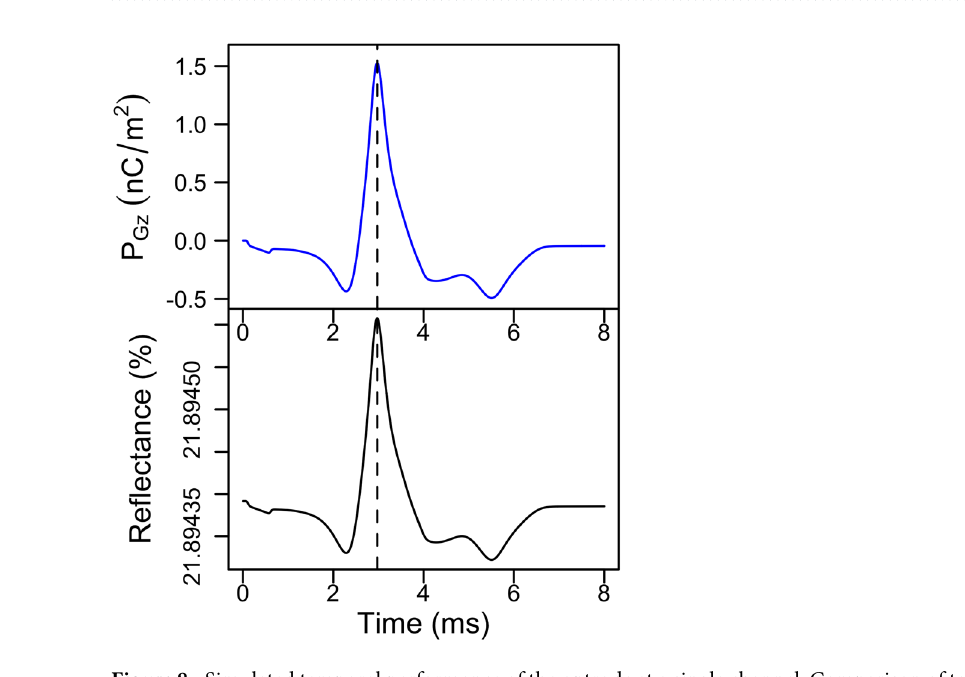
Channel cross-talk. It is clear from Fig. 9 that changes in the polarisation of the LC are confined to LC regions directly below the vias. It can also be noted that changes in P Gz occurred in channels not directly below the neu- ron. We attribute this to the spread of extracellular potential in physiological solution to vias further away from the neuron source, thus following multiple parallel channel paths to the ground electrode via the LC layer. This explains the reduction in the peak value of P Gz at a given optrode when a multi-channel device is simulated com- pared to a single channel device.